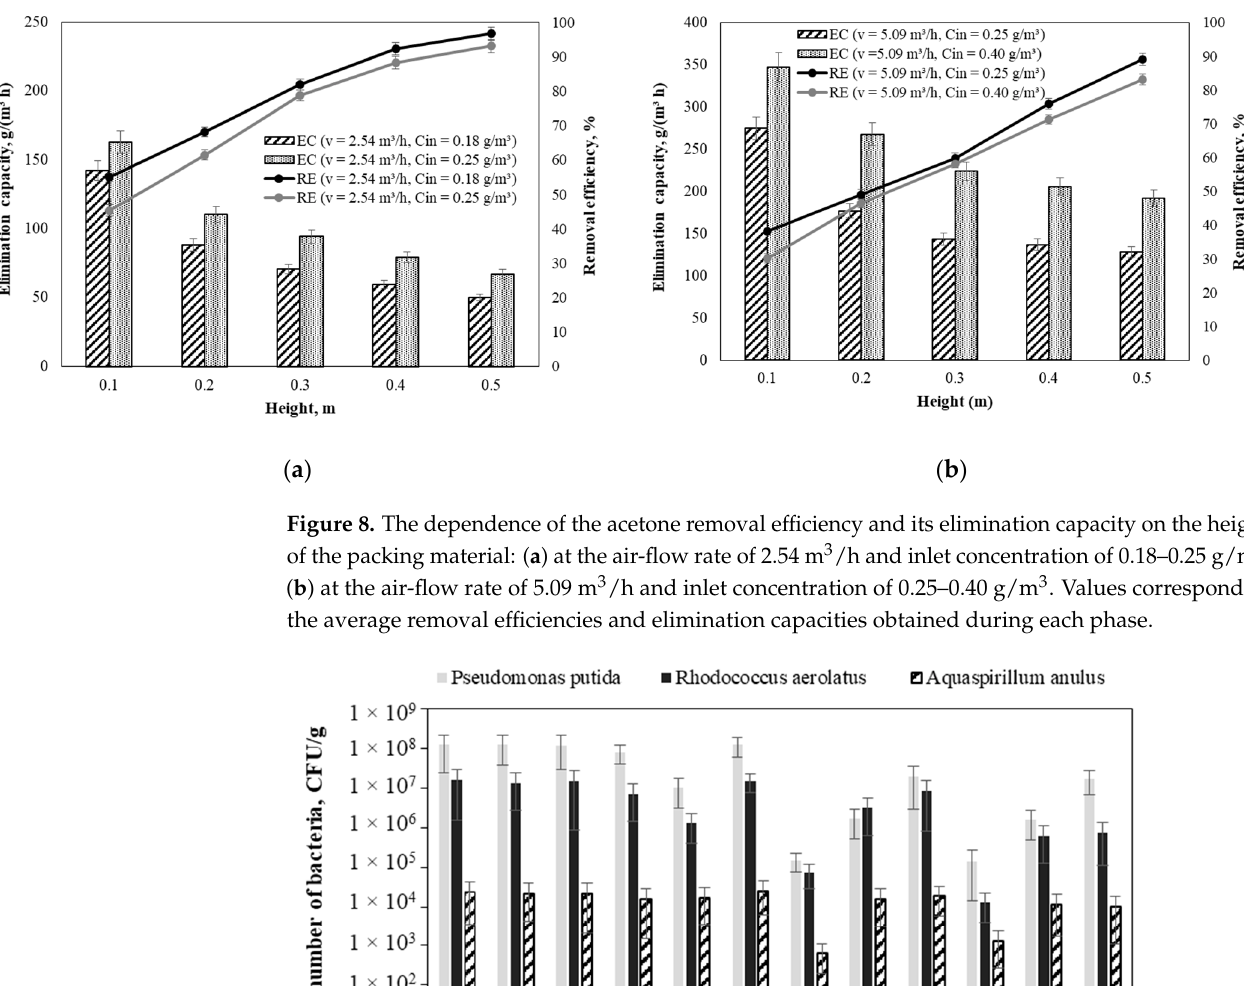
Figure 7. Influence of acetone inlet loading on the elimination capacity of the biotrickling filter.